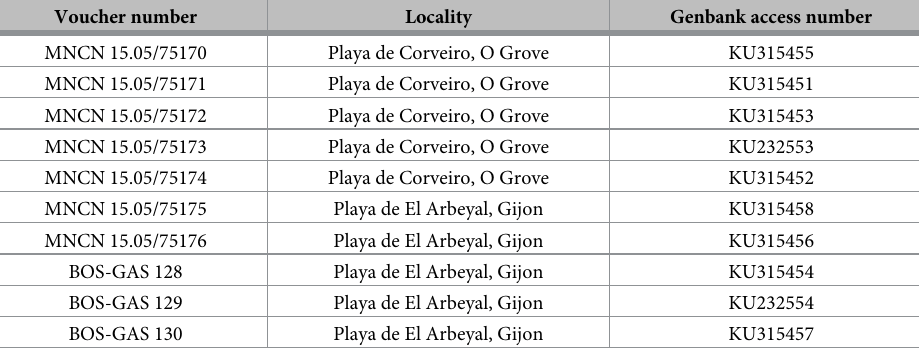
Table 2. Summary of the live collected and barcoded material deposited in public repositories. Voucher